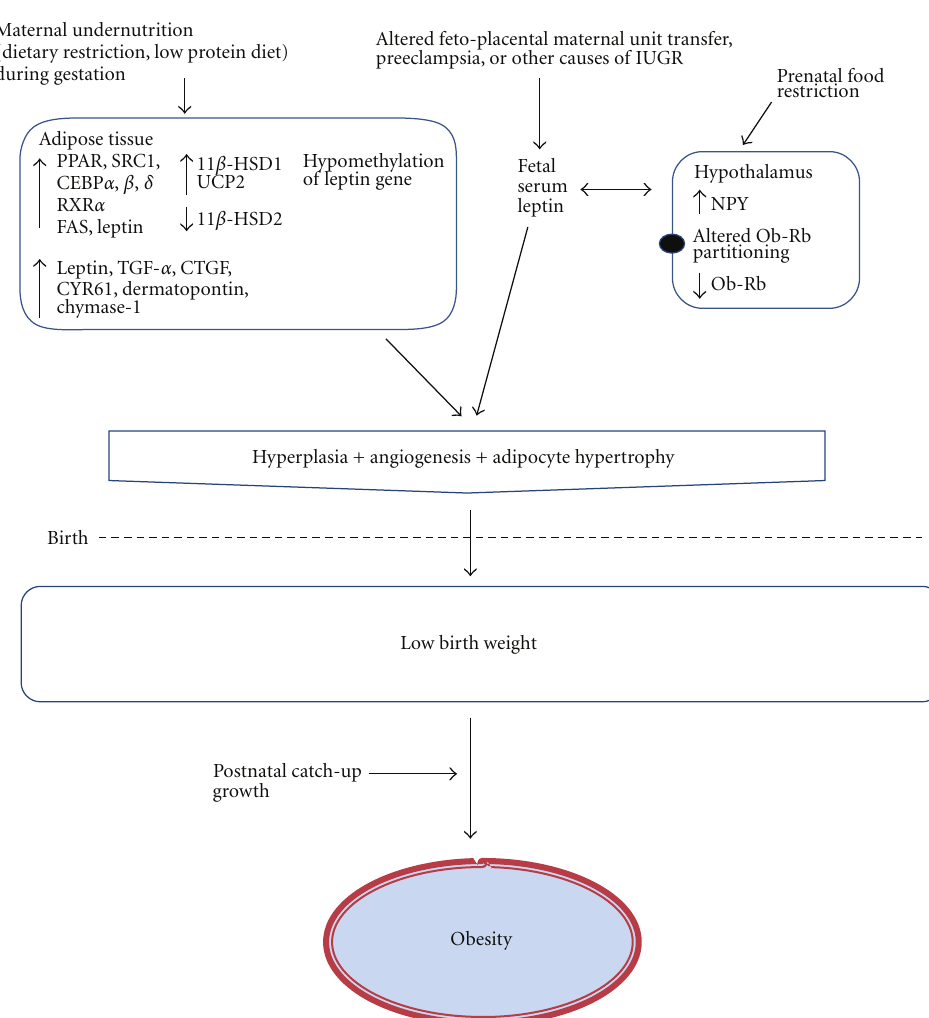
Figure 2: Schematic overview depicting key postulated molecular changes in adipose tissue and in hormonal status in the fetus and that may be involved in the development of later obesity following intrauterine growth restriction. For full explanation and definitions, see (Section 5). TGF- α 1 (transforming growth factor alpha-1), CTGF (connective tissue growth factor), CYR61 (cysteine-rich, angiogenic inducer, 61), dermatopontin, and